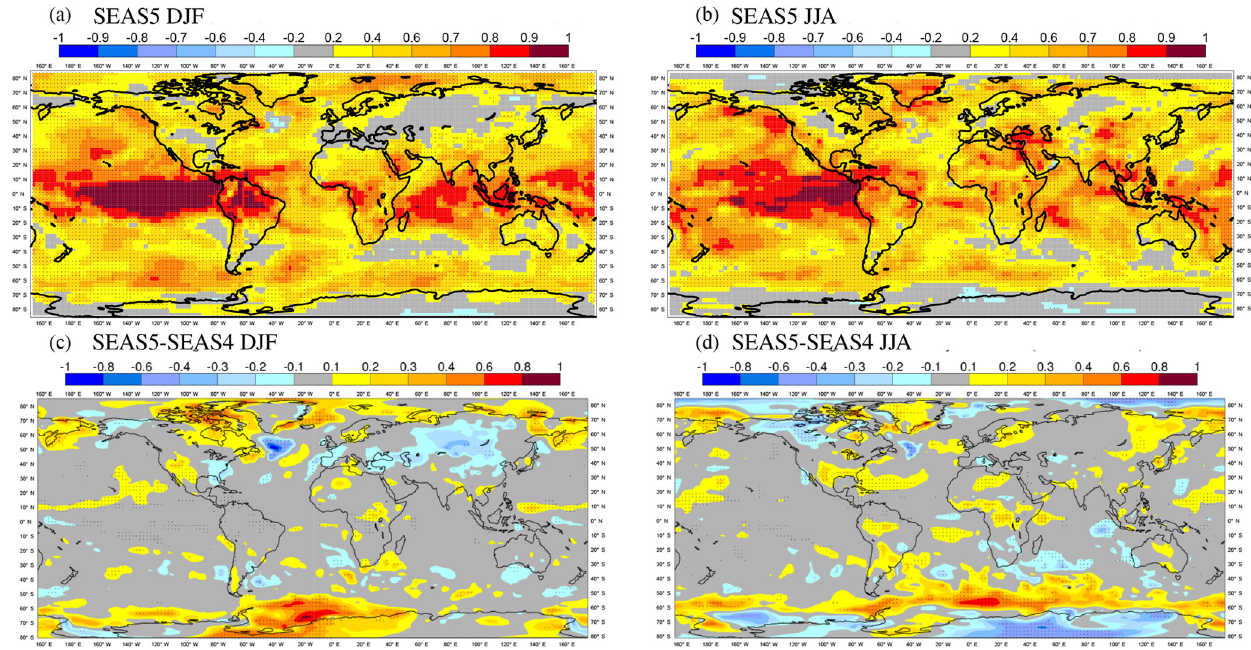
Figure 19. (a, b) Anomaly correlation map of the ensemble-mean SEAS5 mean 2m temperature forecast for DJF (a, c) and JJA (b, d) at 1 month forecast lead. 2m temperature is verified with ERA-Interim data. Locations with correlation values different from zero at the 5% significance level are highlighted by dots. (c, d) Difference between SEAS5 and SEAS4 anomaly correlation, with 25 ensemble members used in each. Locations where the correlation values are different at a 5% significance level are highlighted by